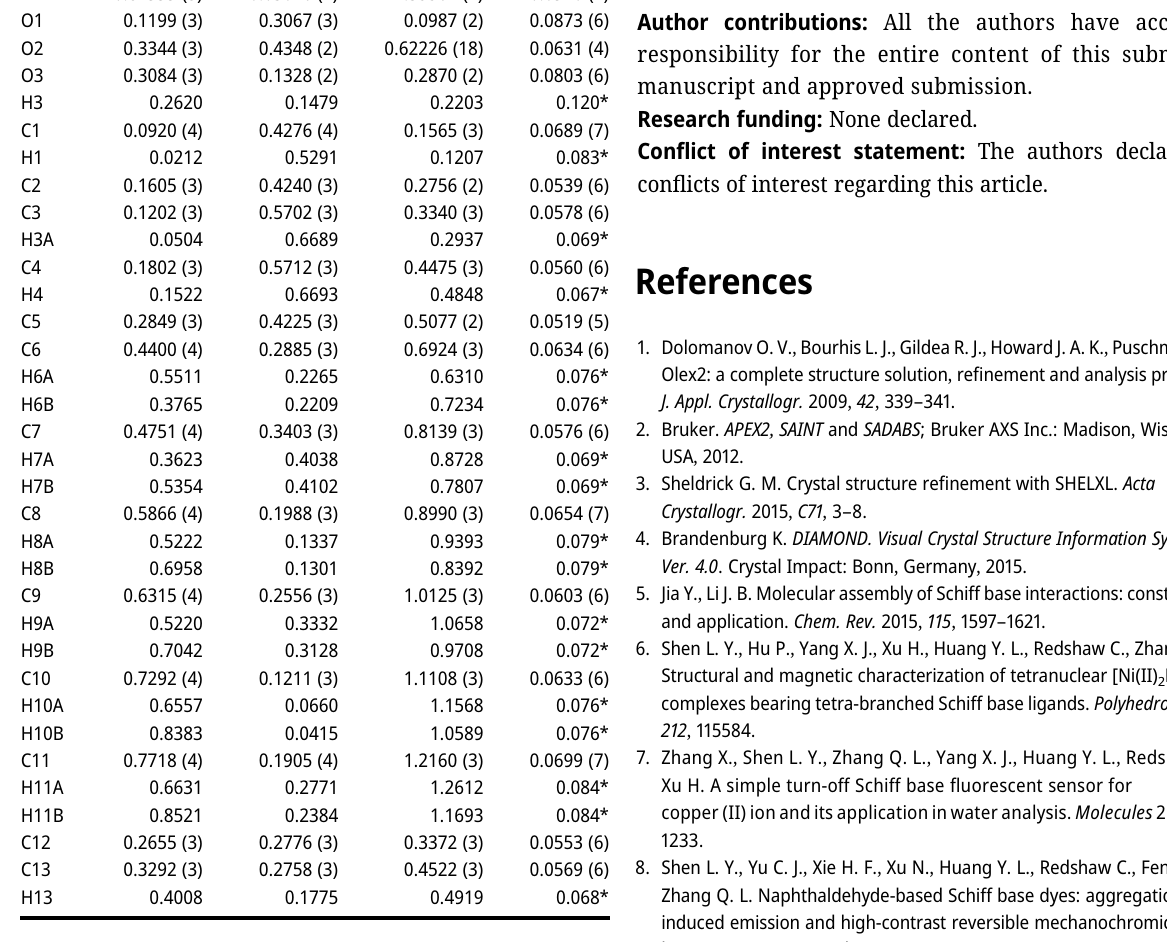
compound forms a zigzag structure. The molecule contains the intramolecular hydrogen bond O3 — H3 ⋯ O1, and there is C11 — H11B ⋯ O1 hydrogen bond between the molecules.